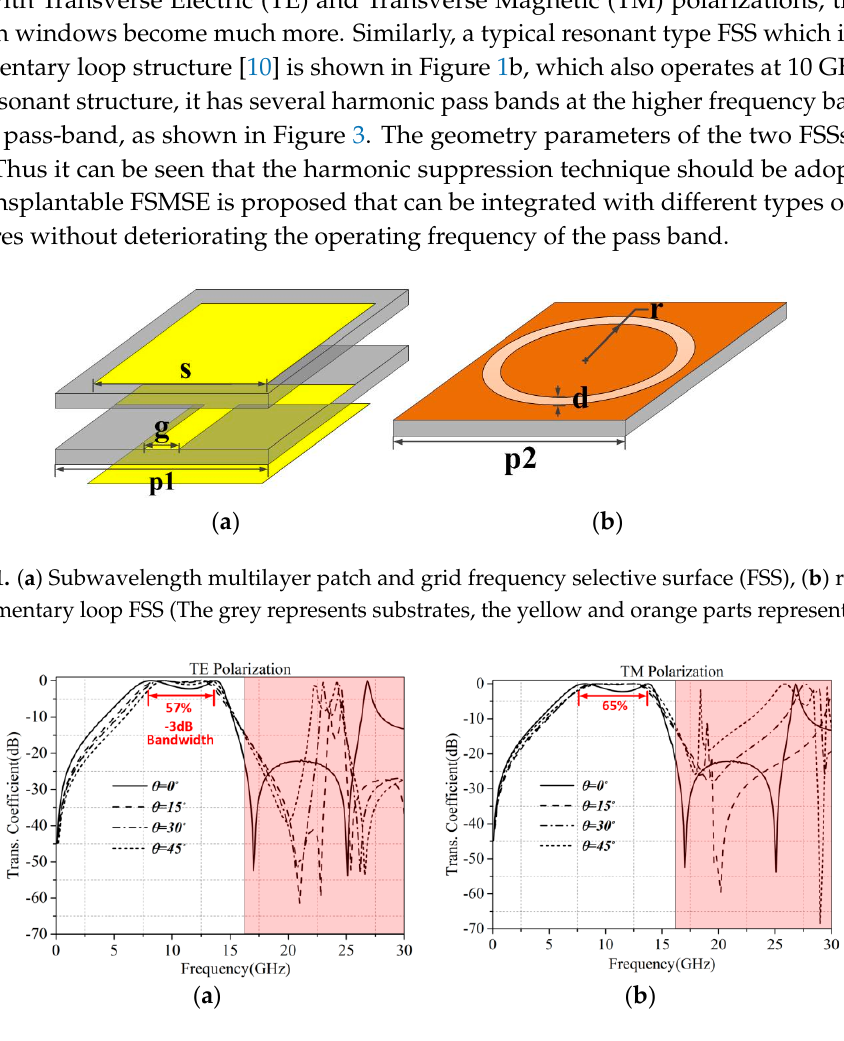
Figure 3. Transmission coefficient characteristics for oblique incidences on the resonant complementary loop FSS for ( a ) TE polarization and ( b ) TM polarization (The red shadow represents harmonic transmission bands).